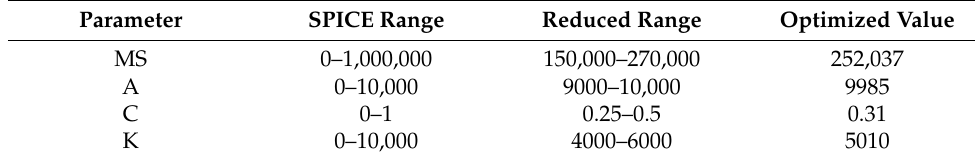
Table 3. Allowable ranges and optimized values for Jiles–Atherton model